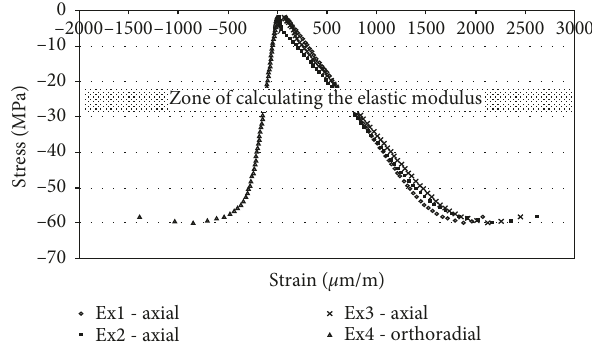
Figure 10: Stress vs. strain of the compressive strength test for an arbitrarily chosen specimen.